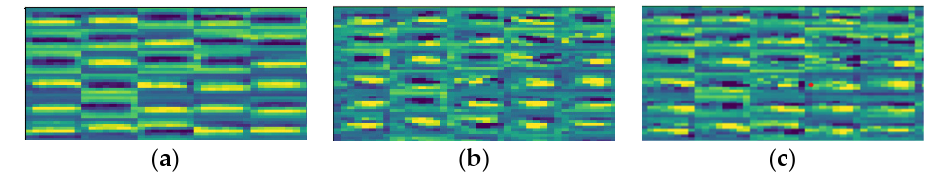
Figure 6. High-level image characteristics of three penetration states. ( a ) Excessive penetration, ( b ) non-penetration, and ( c ) full penetration. Table 2. Validation accuracy in three penetration states (VGG16, dual-input).